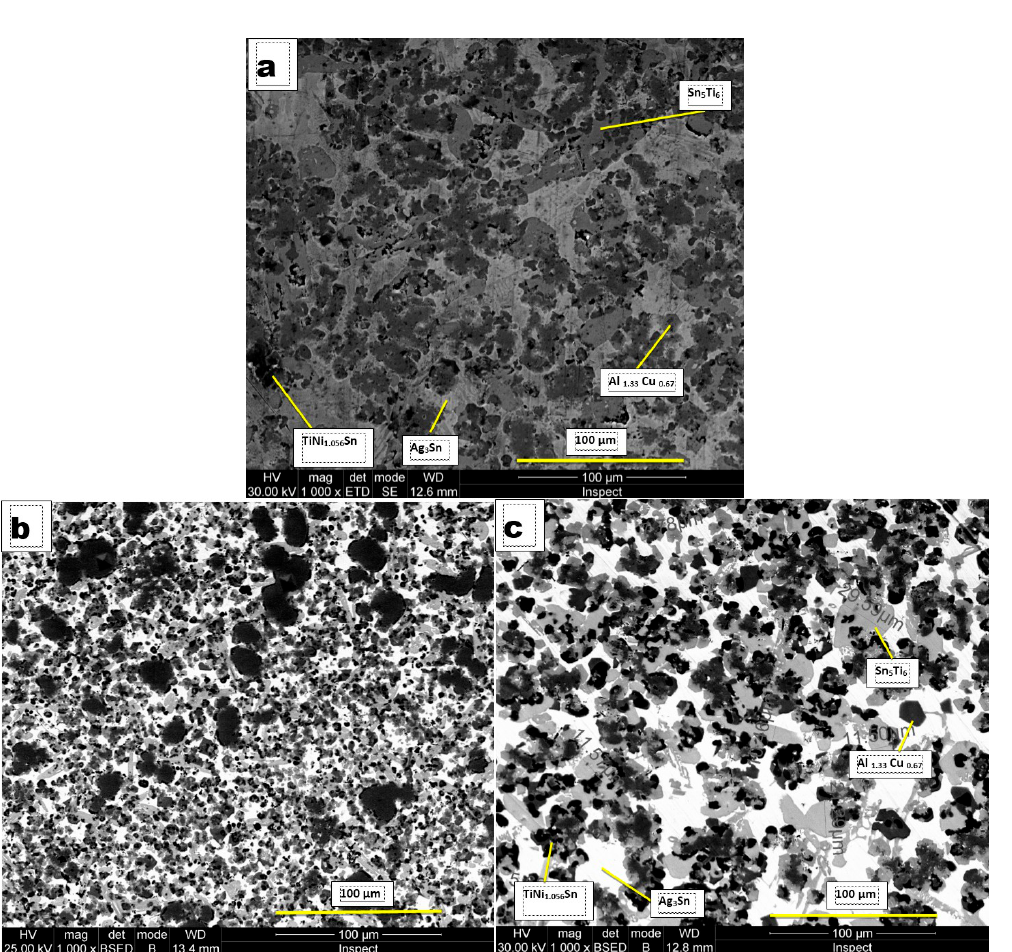
Figure 2. Microstructure of the equimolar AlAgCuNiSnTi alloy: ( a ) cast ingot, 50 mm diameter, 10 mm thick; ( b ) ≈ 1 mm thick cast strip; ( c ) sample homogenized at 800 °C.